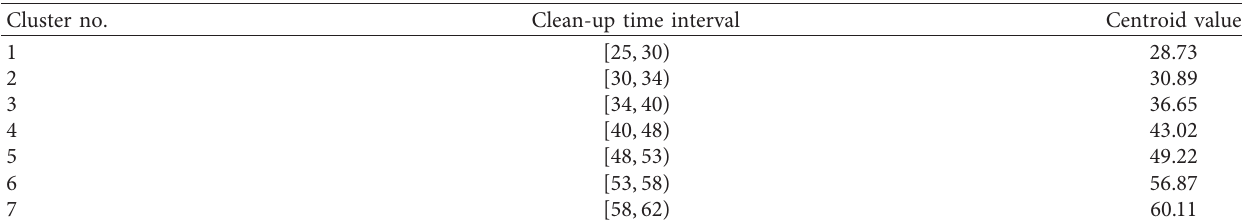
Table 5: Clustering